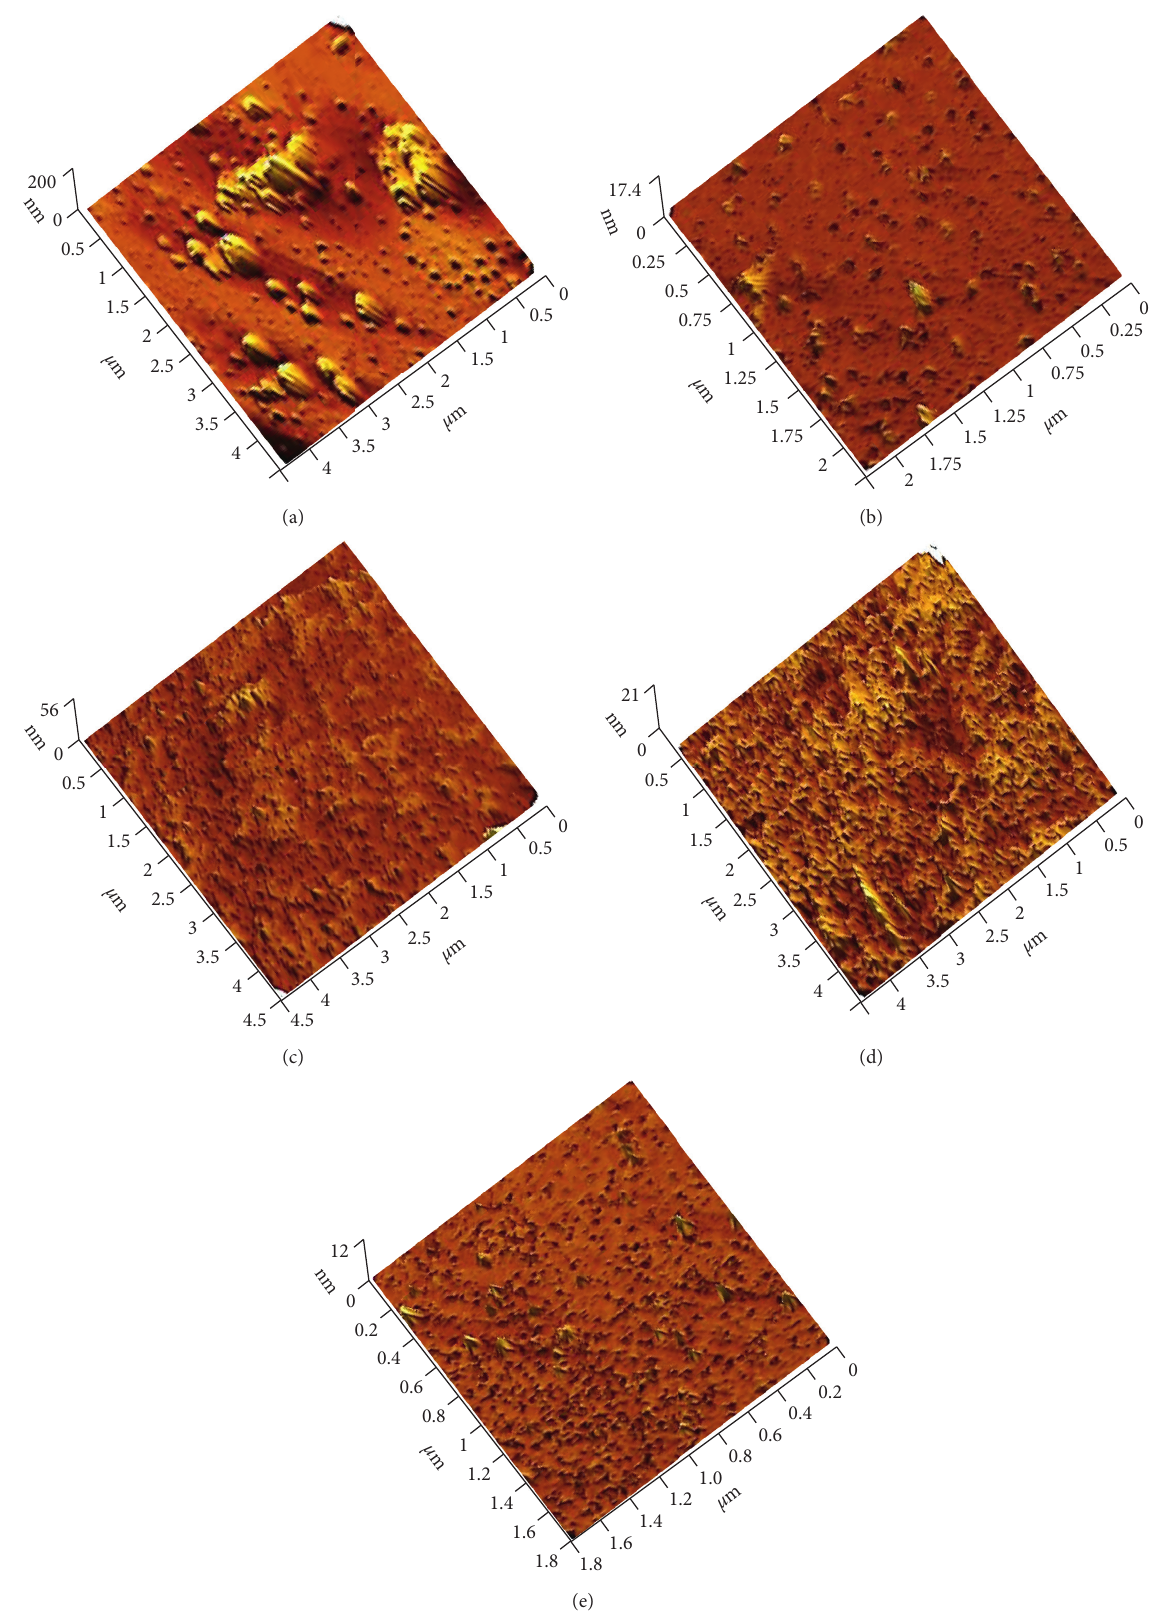
Figure 10: AFM analysis of GTC (0% to 40%). (a) GTC-0; (b) GTC-10; (c) GTC-20; (d) GTC-30; (e)